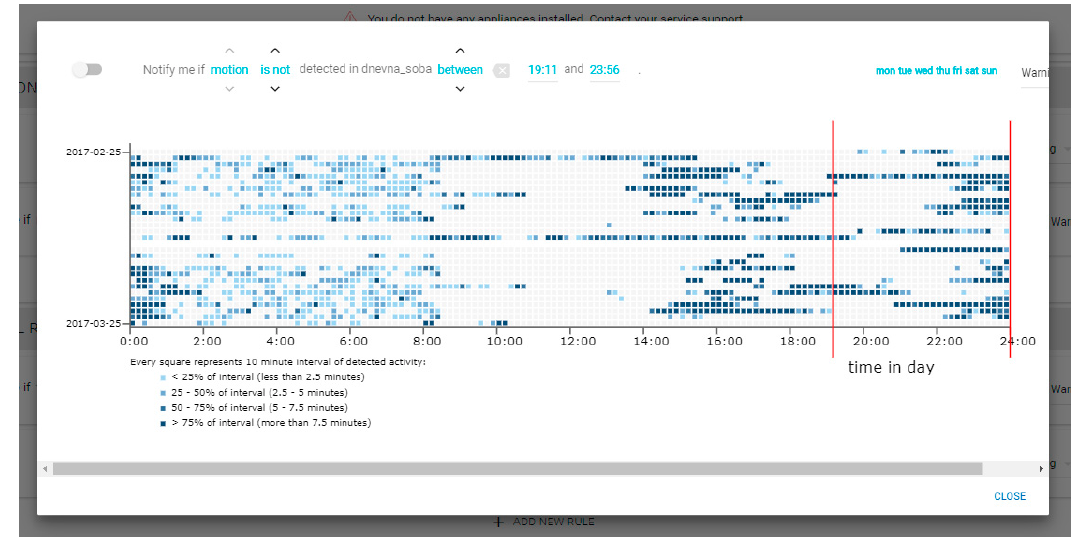
Figure 6. The rule details view.